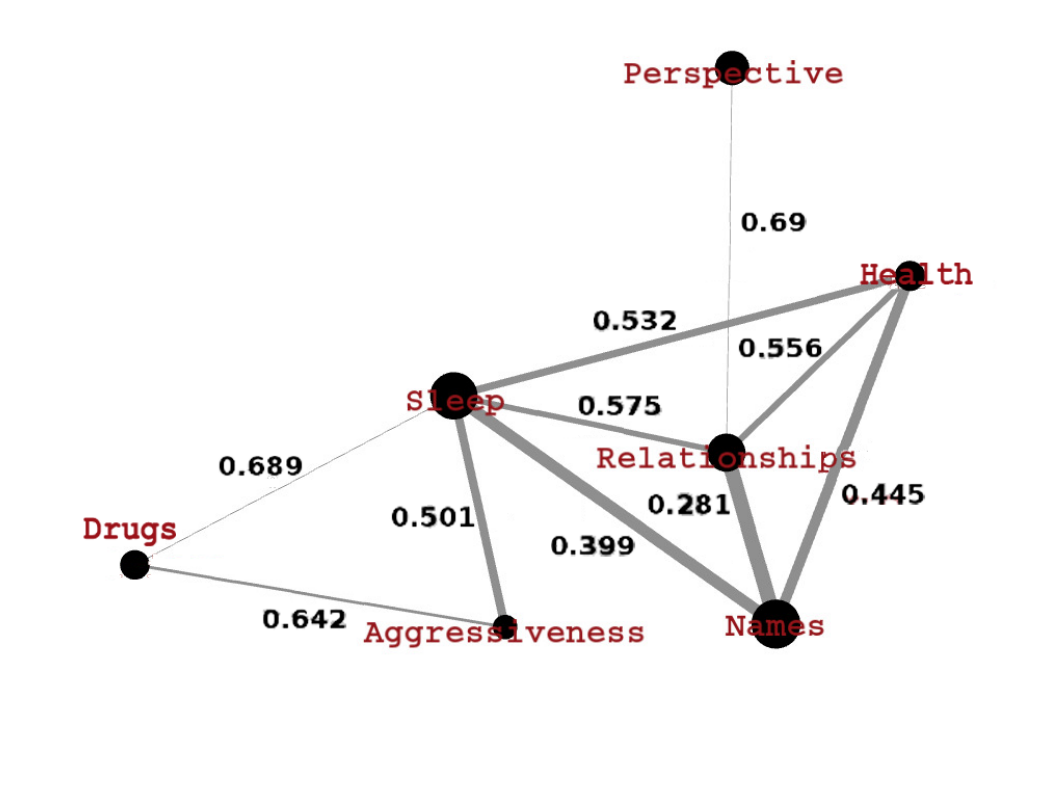
Figure 5. Clusters of words in R d , depicted as a graph. The nodes have been labeled by topic. The clusters were obtained after applying word2vec and before transformation R ( w ) .